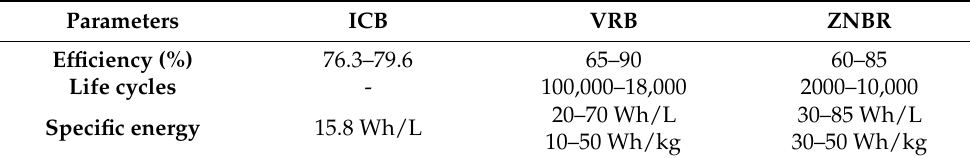
Table 8. Comparison of the main technical parameters of the different RFBs.